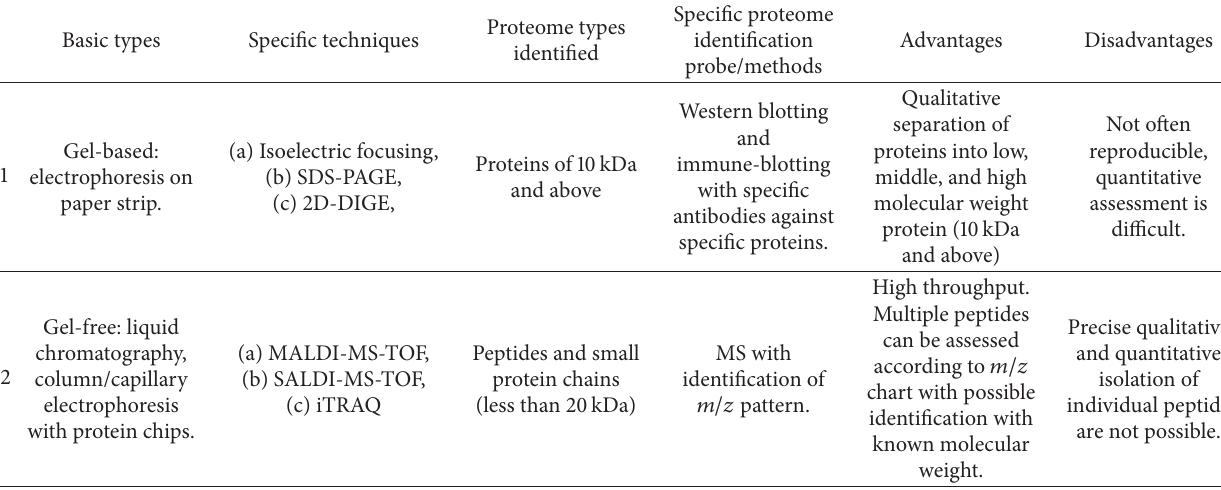
Table 3: Salient features of techniques for urinary proteome